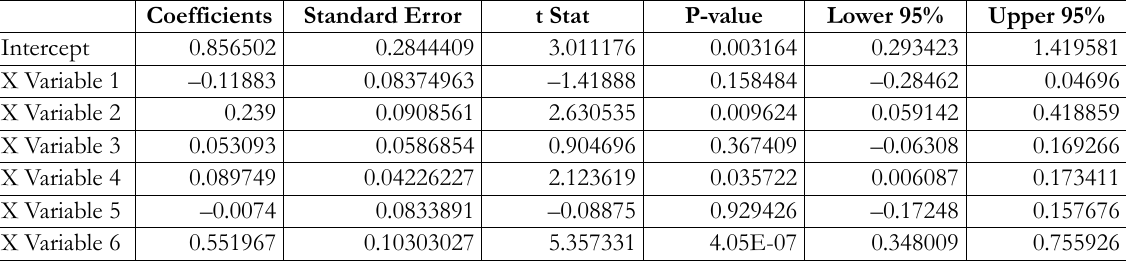
Table 15. Analysis Output of Incentives for lecturers and students against increased usage of ICTs